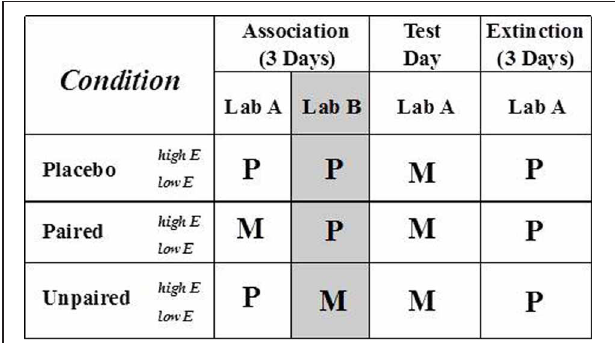
FIGURE 2 | Study design and experimental conditions. See text for details. M, methylphenidate; P, placebo.